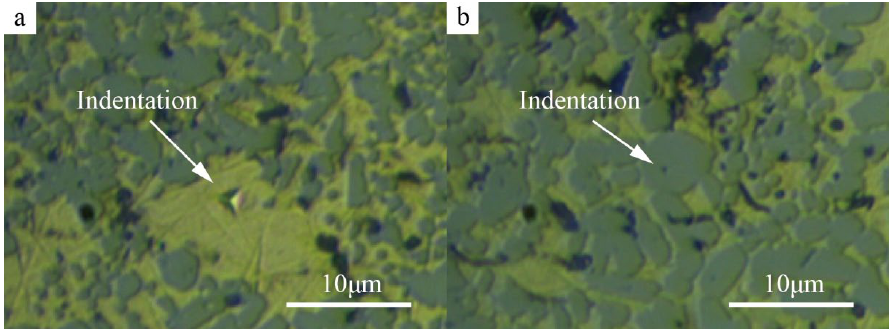
Fig. 11 Micrograph of micro-hardness test: (a) indentation on the metal phase, (b) indentation on the ceramic